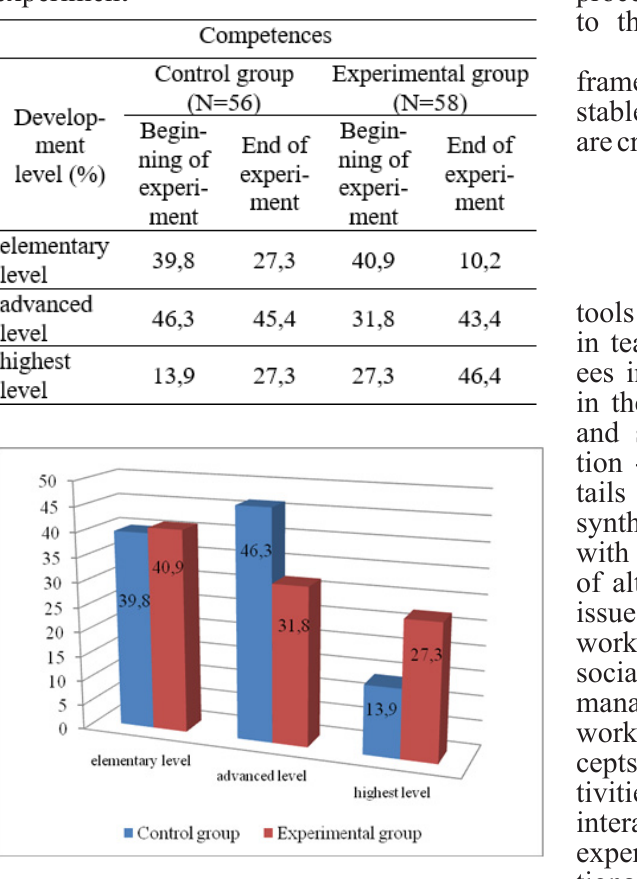
Figure 4. Comparison of the